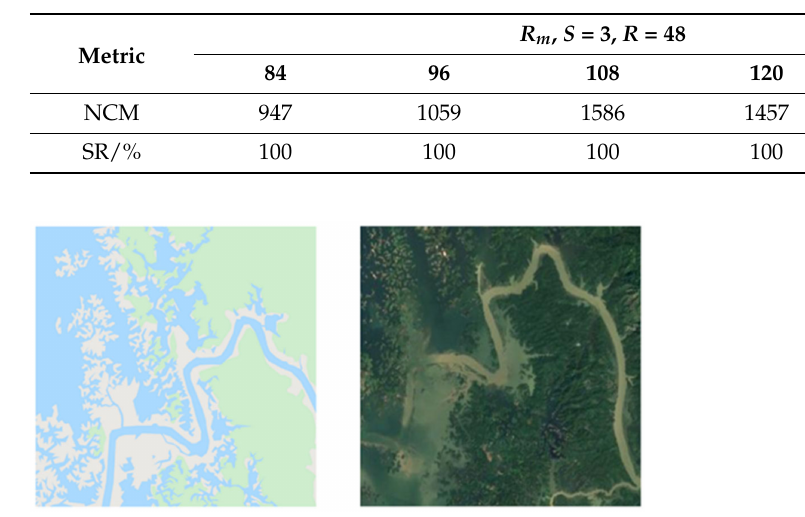
Table 4. The results of the parameter R m .